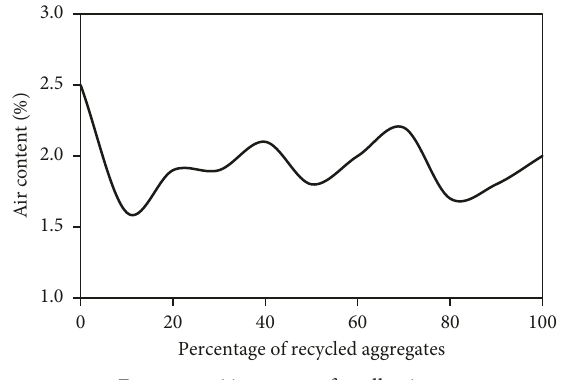
Figure 7: Air content for all mixes.